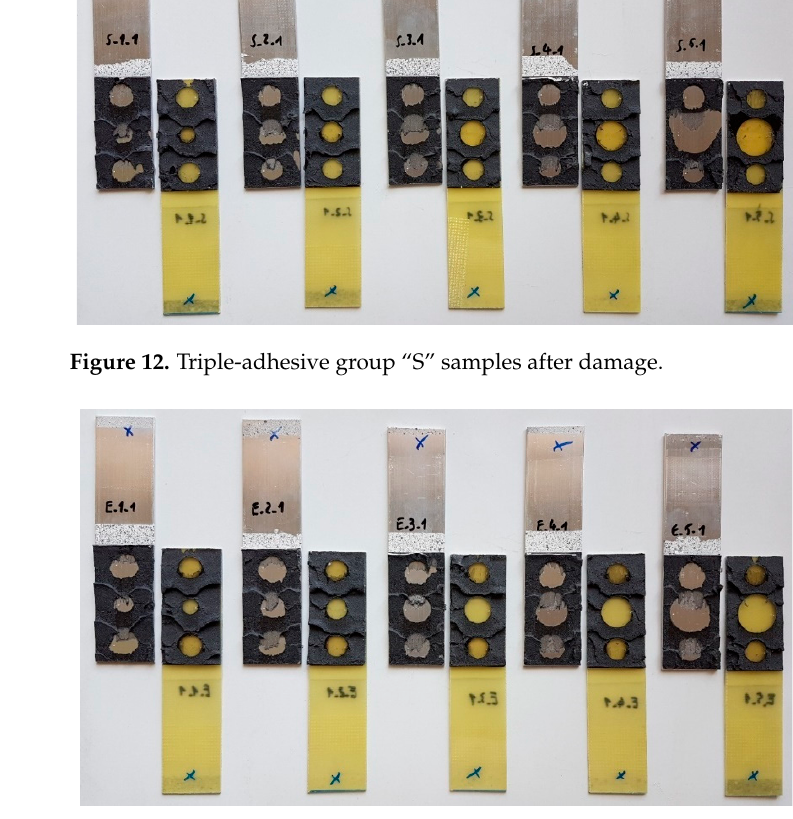
Figure 13. Triple-adhesive group “E” samples after damage.